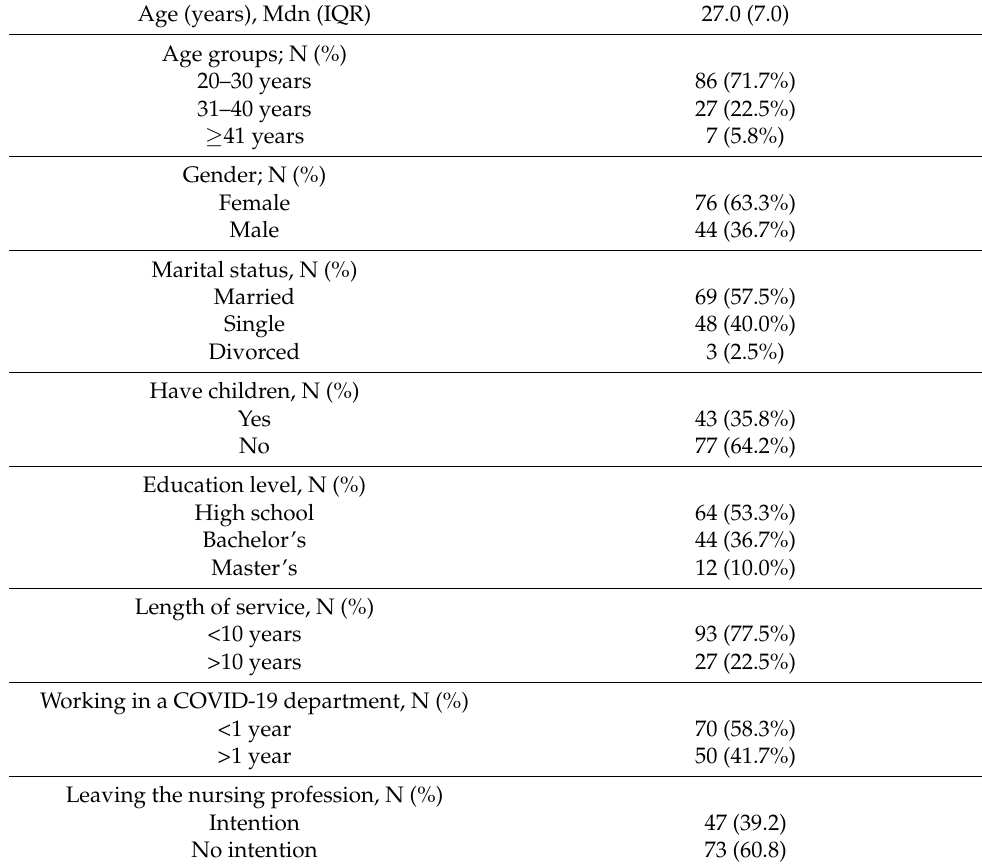
Table 1. Sociodemographic characteristics of study group; N =